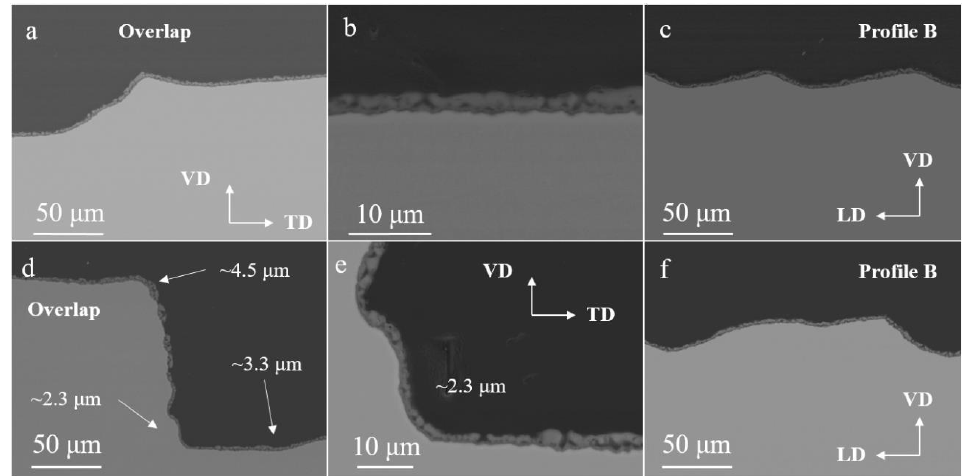
Figure 12. Cross-section SEM of B1-PEO ( a – c ) and B2-PEO ( d – f ) coatings. Images ( a , b , d , e ) correspond to the VD-TD plane (across the bridge macrostructure) at the bridge overlap region. Images ( c , f ) correspond to the VD-LD plane across the micro-grooves of the macrostructures along the profile B (marked in Figure 4) approximately.